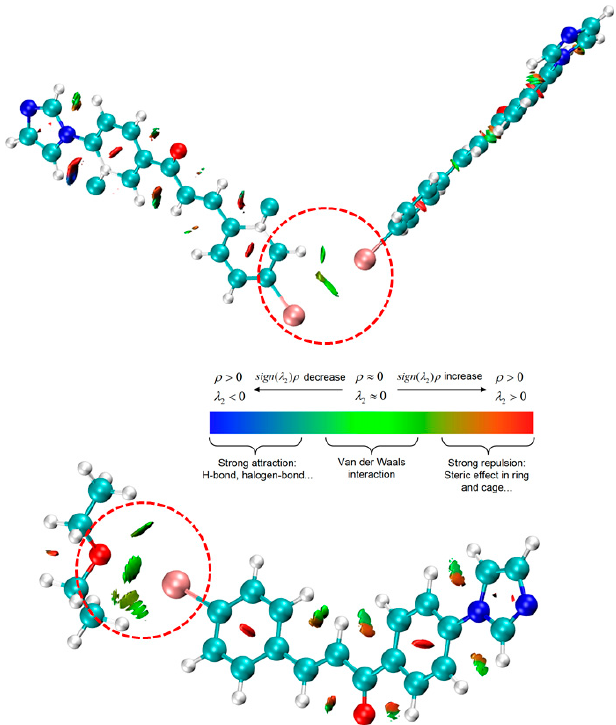
Figure 5. The molecular fragments {(4I-L) ··· (4I-L)} ( top ) and {(4I-L) ··· (Et 2 O)} ( bottom ) used for the theoretical calculations of the interaction energies ( E int ) overlapped with NCI calculations showing weak intermolecular interactions of interest in red dashed circles.